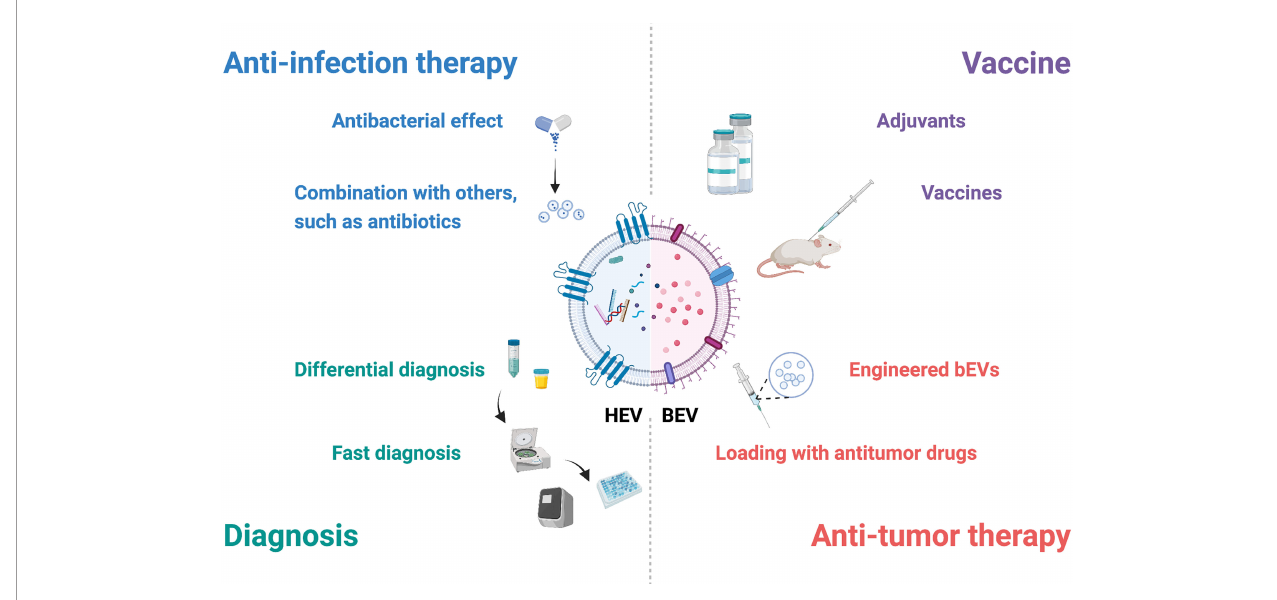
FIGURE 2 | Potential applications of EVs in interactions between the host and bacteria. EVs have potential in diagnosis, anti-infection therapy, vaccines and antitumor therapy. Combined with speci fi c molecules and other techniques, hEVs may be utilized for fast diagnosis and differential diagnosis. HEVs from speci fi c cells, such as mesenchymal stem cells, possess antibacterial effects, and hEVs combined with other materials may show better therapeutic effects. BEVs contain many pathogen-associated molecular patterns that provoke innate and adaptive immune responses and are suitable for adjuvants and vaccines. Engineered bEVs express speci fi c proteins that demonstrate antitumor effects. Meanwhile, these bEVs are able to load antitumor drugs, showing potential in antitumor therapy. This fi gure was created with